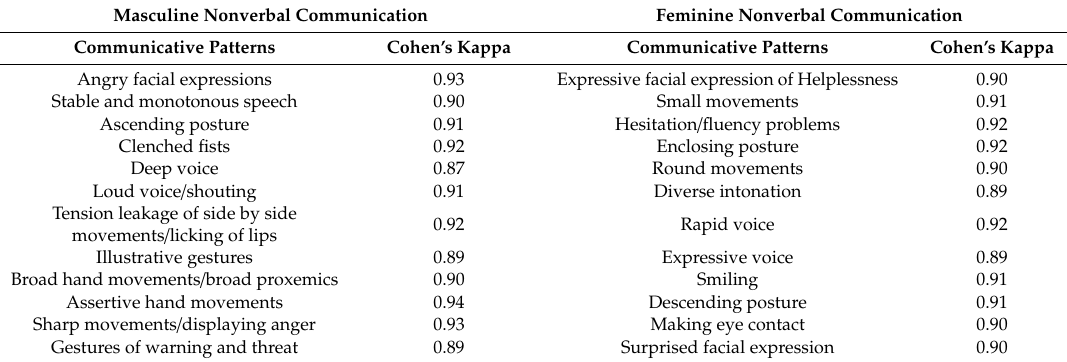
Table 3. Gendered Nonverbal Communicative Structure (NCS) and Cohen’s Kappa Reliabilities. Masculine Nonverbal Communication Feminine Nonverbal